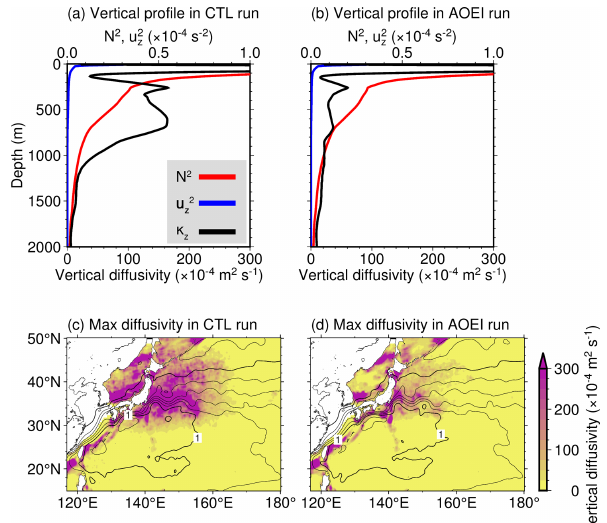
Figure 8. Vertical diffusivity (black), and squared buoyancy fre- quency (red) and shear (blue) averaged over the KE region (30– 40 ◦ N, 140–160 ◦ E) for the whole experimental period in the (a) CTL and (b) AOEI runs. Maxima of the averaged vertical diffusiv- ity for the whole experimental period within 300–1000m depth in the (c) CTL and (d) AOEI runs. Black contours show SSH averaged over the whole period. Thin (thick) contour intervals are 0.2 (1)m.